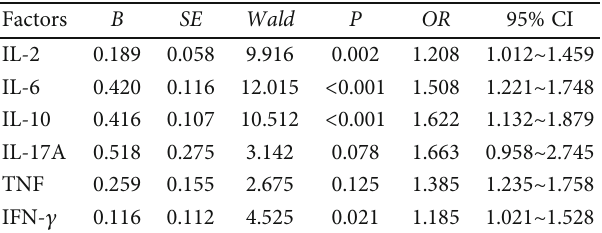
Table 7: Multivariate COX analysis of the relationship between external blood in fl ammatory factors and stroke in patients with AF.